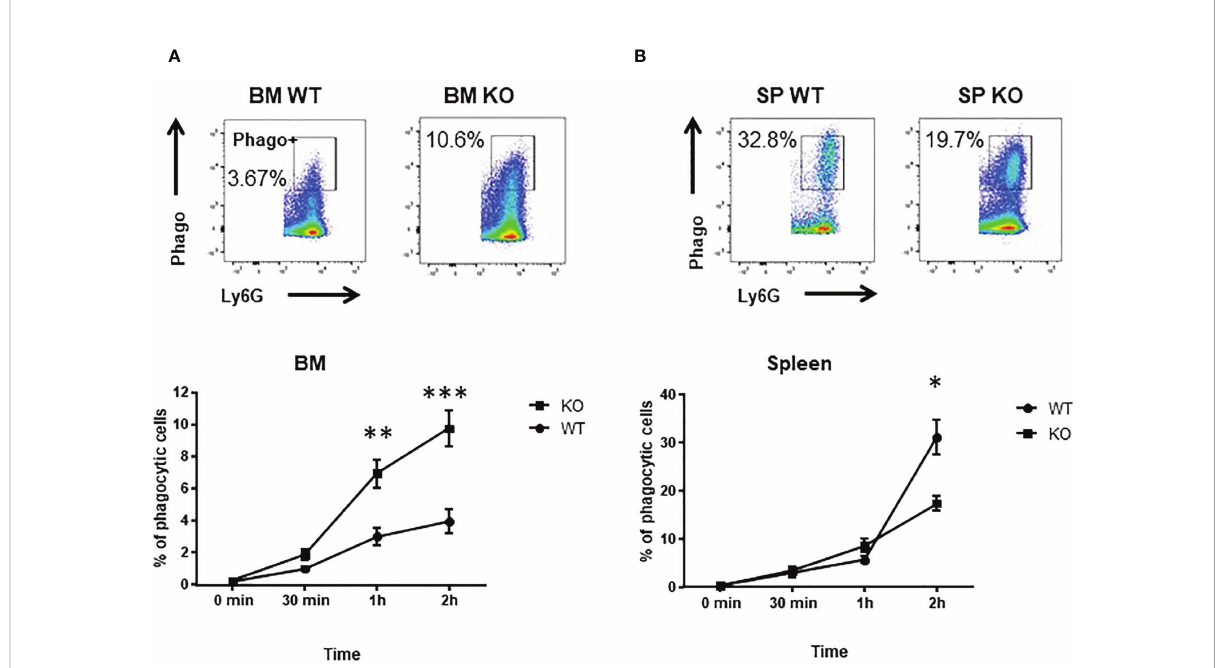
FIGURE 2 spleen Cxcr2-/- neutrophils have an impaired phagocytosis ability. (A) To measure phagocytosis, BM CD11b+ Ly6G+ neutrophils were incubated with Red E . coli Phrodo bioparticles at 37°C for 0, 30 min, 1h or 2h and analyzed by fl ow cytometry. Upper panel: Gating strategy to identify phagocytic neutrophils (Phago+) in the CD11b+ Ly6G+ fraction at 2h time. Lower panel: Percentage of phagocytic Ly6G+ neutrophils. (B) Same experiment with spleen neutrophils. Results are expressed as the percentage of phagocytic neutrophils in the CD11b+ Ly6G+ population and represent the mean ± SEM of at least 6 animals (Mann-Whitney test, *p < 0.05, **p < 0.01, ***p <